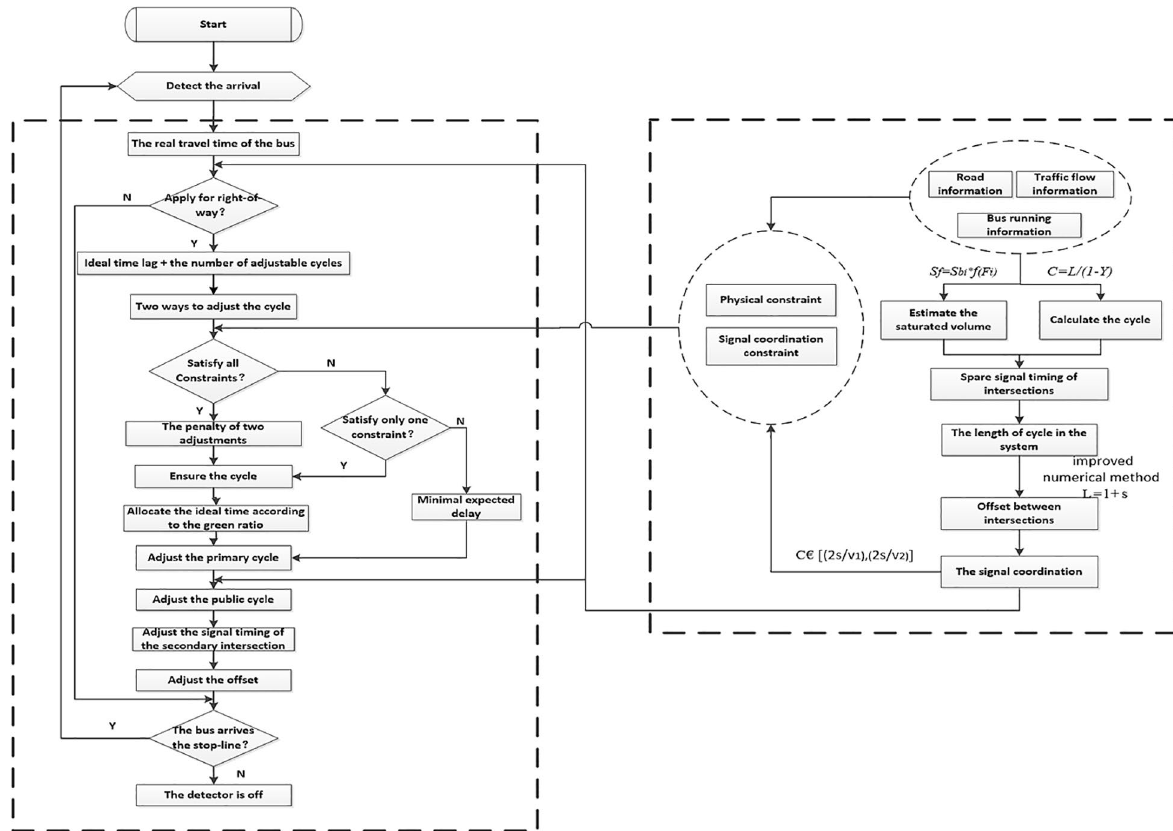
Fig. 1. Flowchart of the pre-detective signal priority strategy with coordination